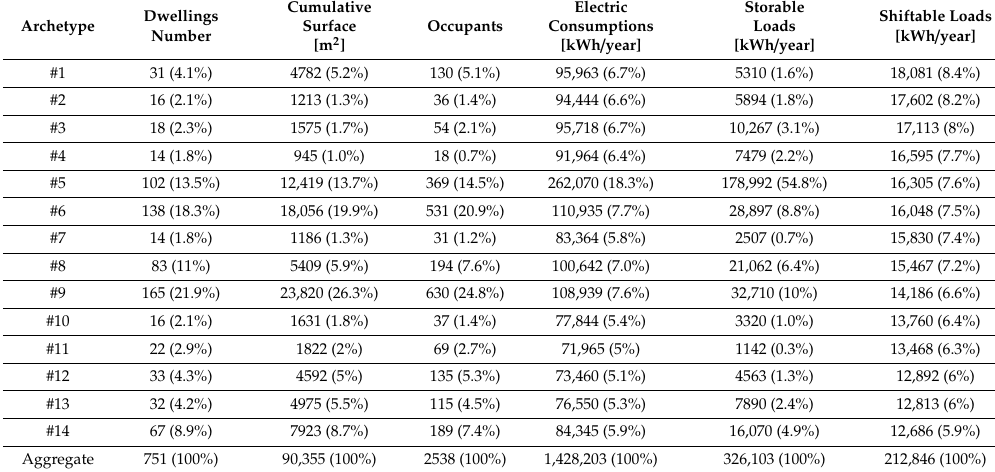
Table 6. Archetypes representativeness.